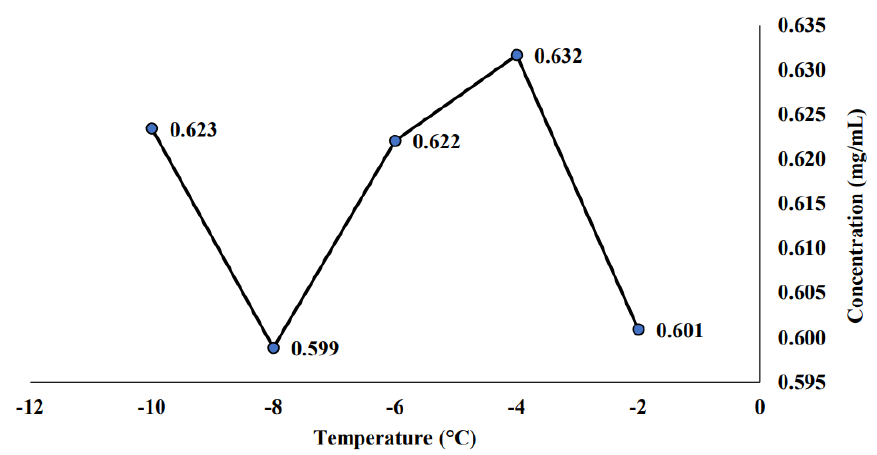
Figure 5. Saponin concentration of sterilized sample at different temperatures.